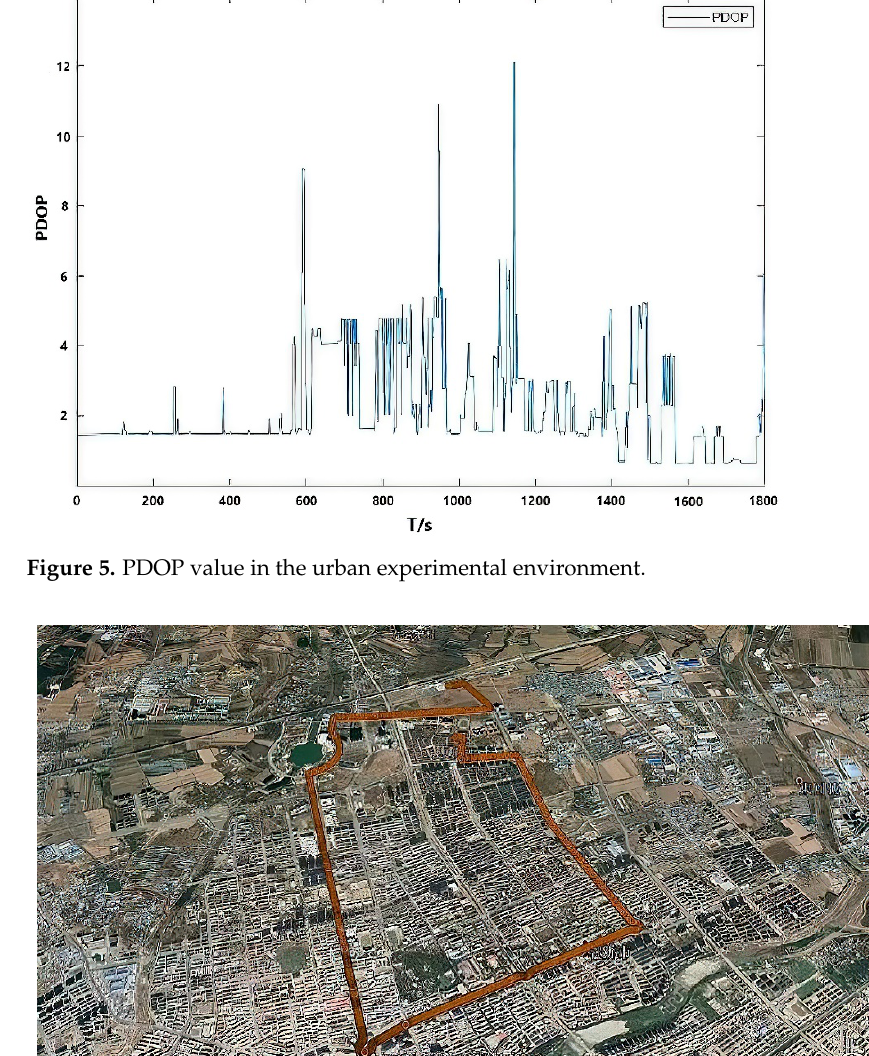
Figure 7. Accelerometer data and gyroscope data.